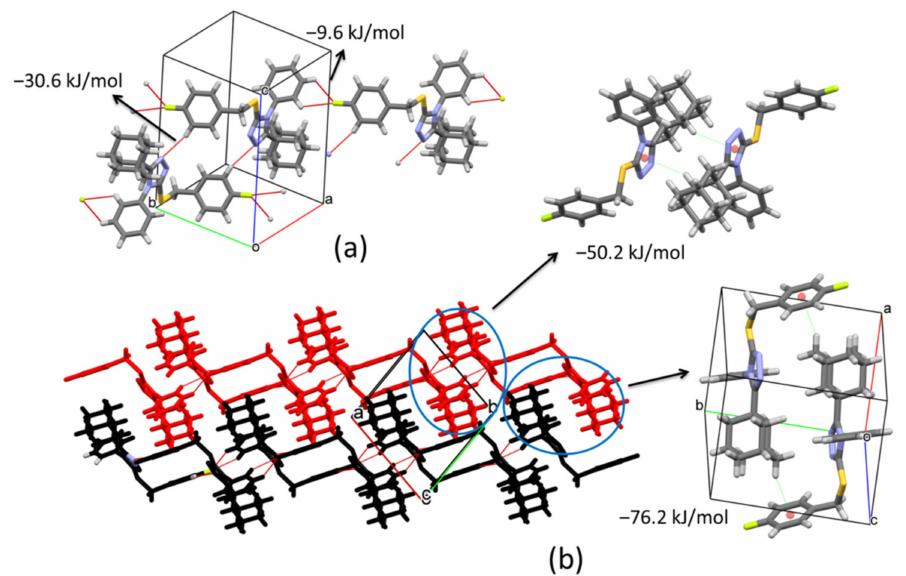
Figure 6. ( a ) C-H ··· N and C-H ··· F hydrogen-bonds joining molecules along [1–10] direction. ( b ) C-H ··· π interactions involved in the formation of (001) sheets. Hirshfeld surfaces (HFs) mapped over d norm only present two red spots correlated to C24-H24 ··· N1 v interactions with H ··· N distances of 2.56 Å. The rest of the